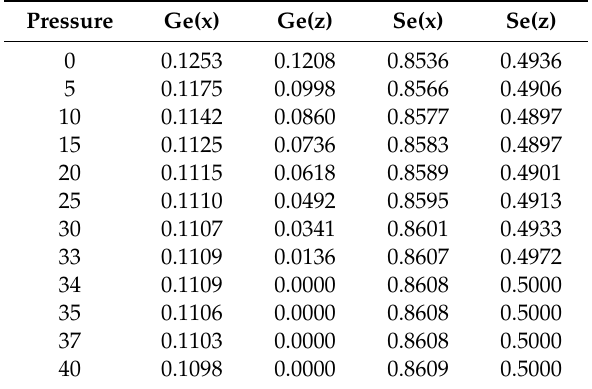
Table 2. 4c Wycko ff positions at (x, 1 / 4, z) of Ge and Se under